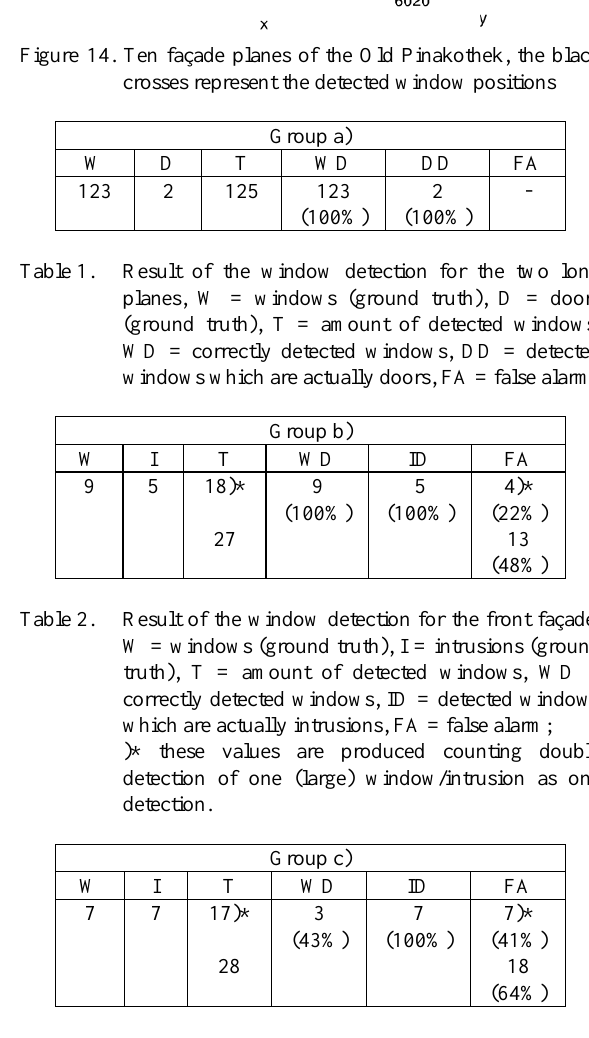
Result of the window detection for the small façade parts, explanation of abbreviations see Table